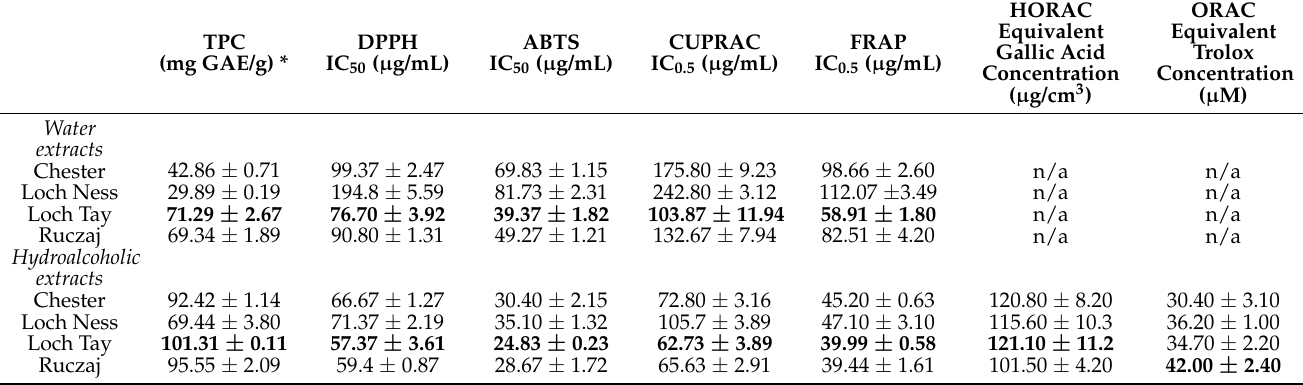
Table 3. Antioxidant activity of blackberry leaves aqueous and hydroalcoholic extracts.